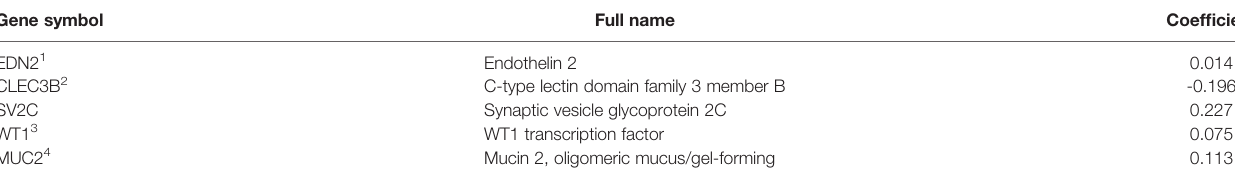
TABLE 2 | Five genes in the signature identi fi ed by the LASSO Cox regression